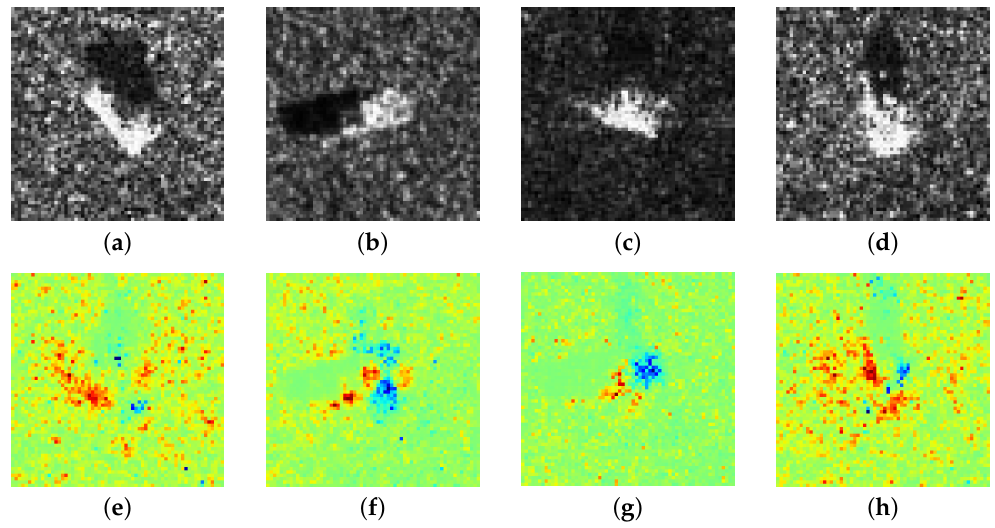
Figure 3. LRP heatmaps of SAR images. ( a – d ) are SAR images of 2S1 (self-propelled artillery), SN_9563 (armor vehicle), D7 (bull dozer), ZIL131 (cargo truck), and ( e – h ) are corresponding LRP